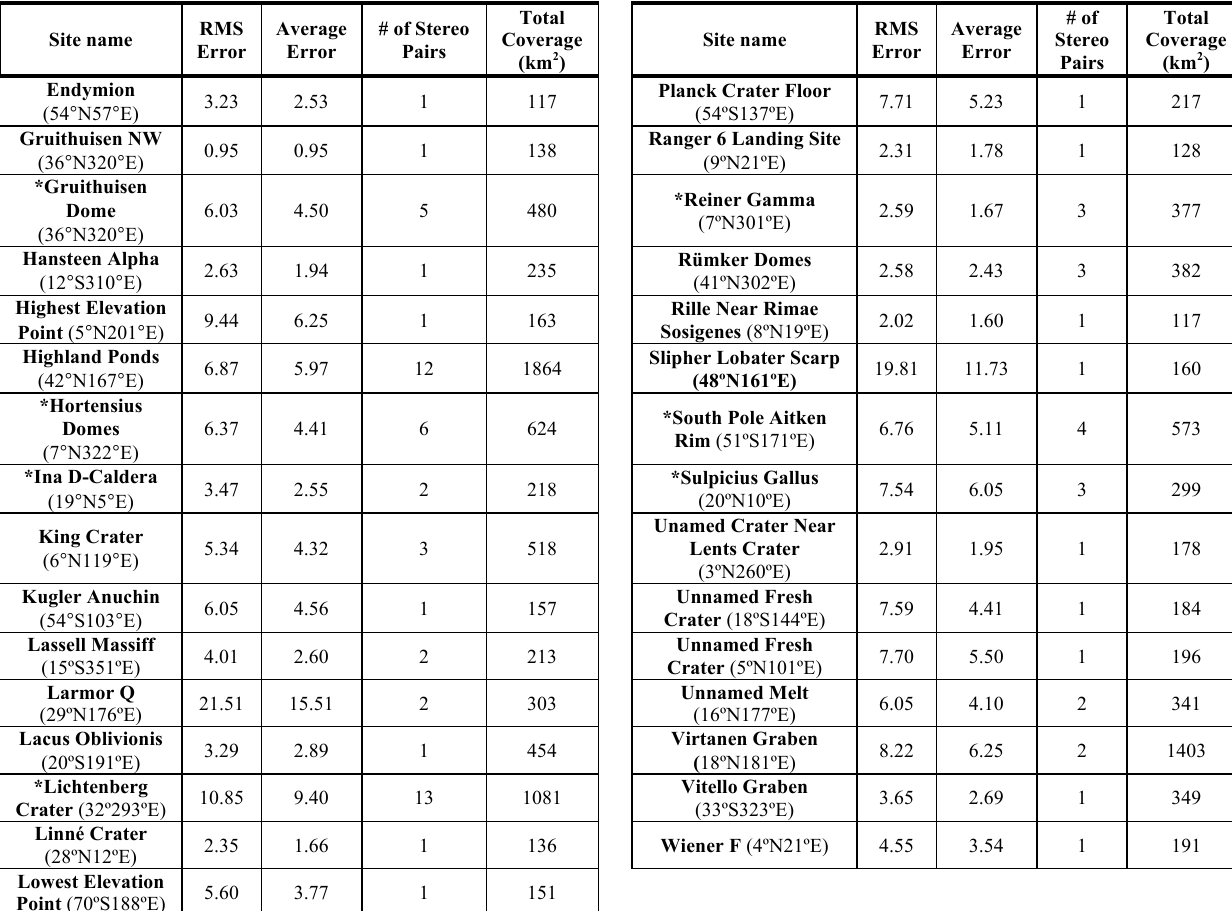
Table 1. Regions of interest processed with NAC DEMs and their coverage and